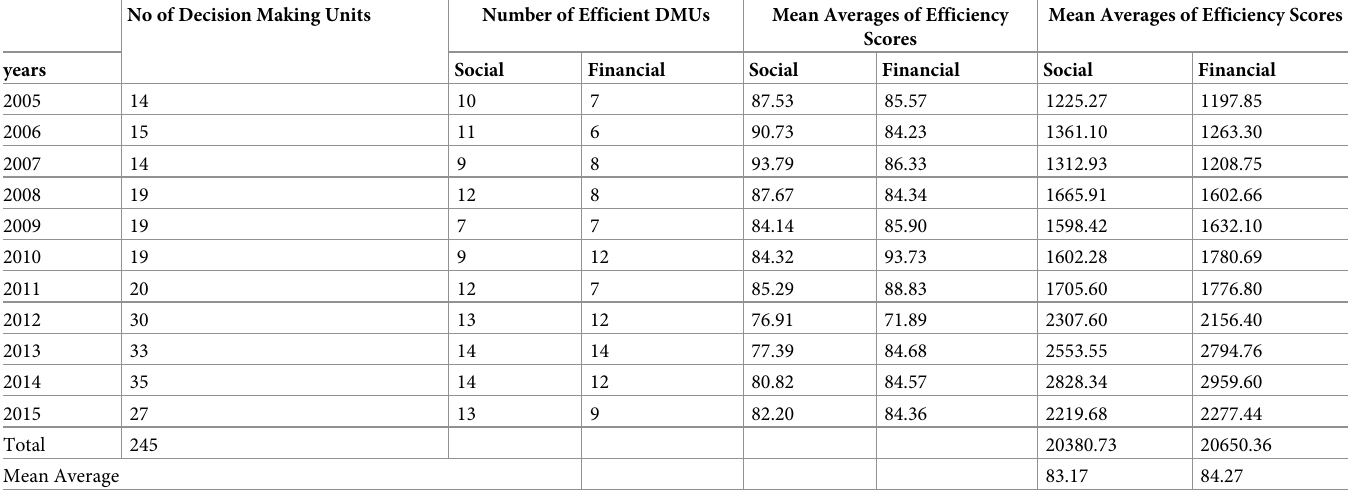
Table 3. Pure technical efficiency (VRS) of partner organizations operating under the Pakistan Poverty Alleviation Fund (PPAF). No of Decision Making